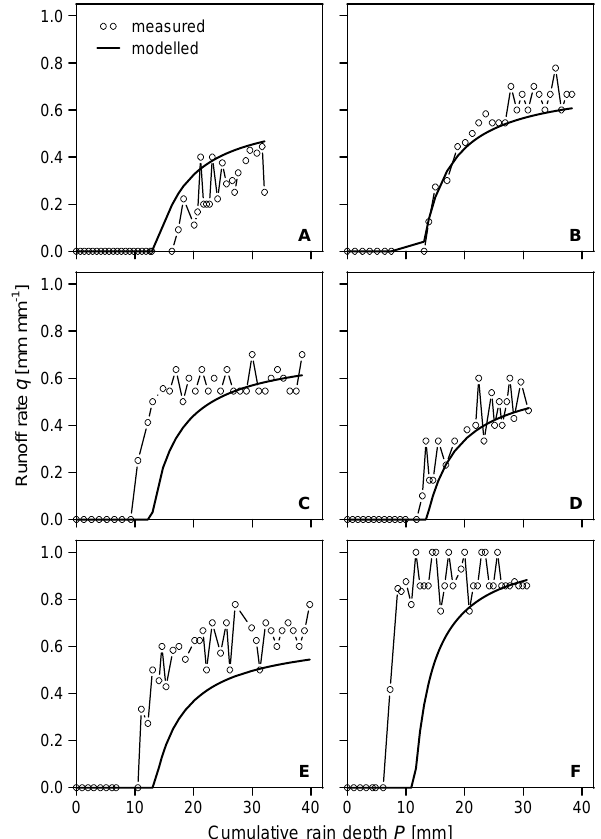
Fig. 2. Examples of instantaneous runoff rates during six events in different months and years on one plot kept under seedbed condi- tions. Note: time since tillage is 0.04 day in panel F, while it is ∼ 3–5 days in all other